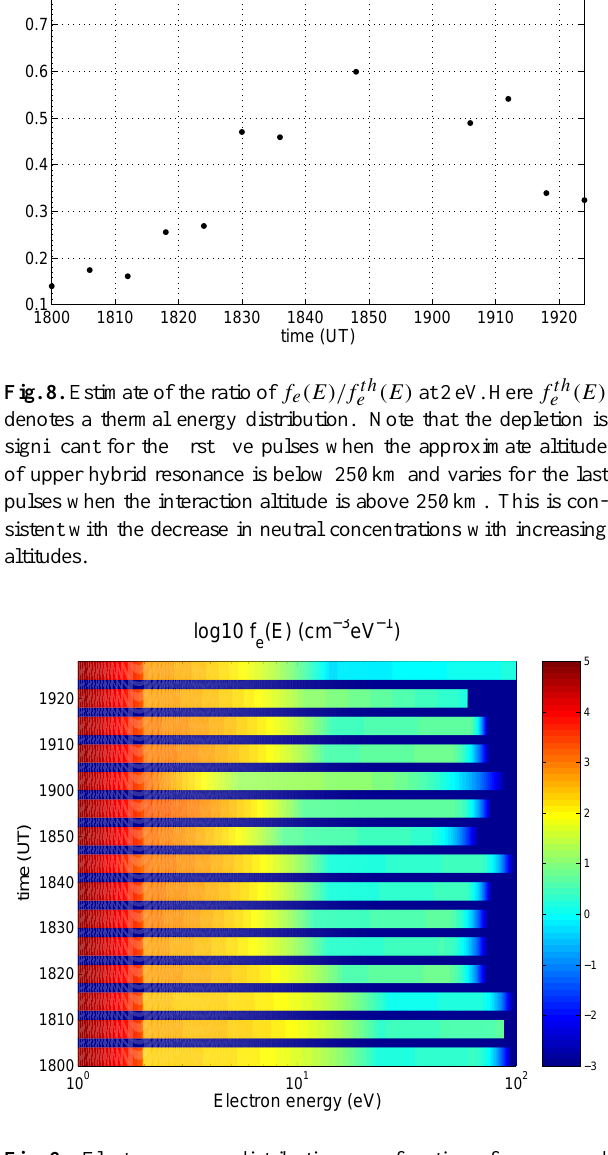
Fig. 9. Electron energy distribution as a function of energy and